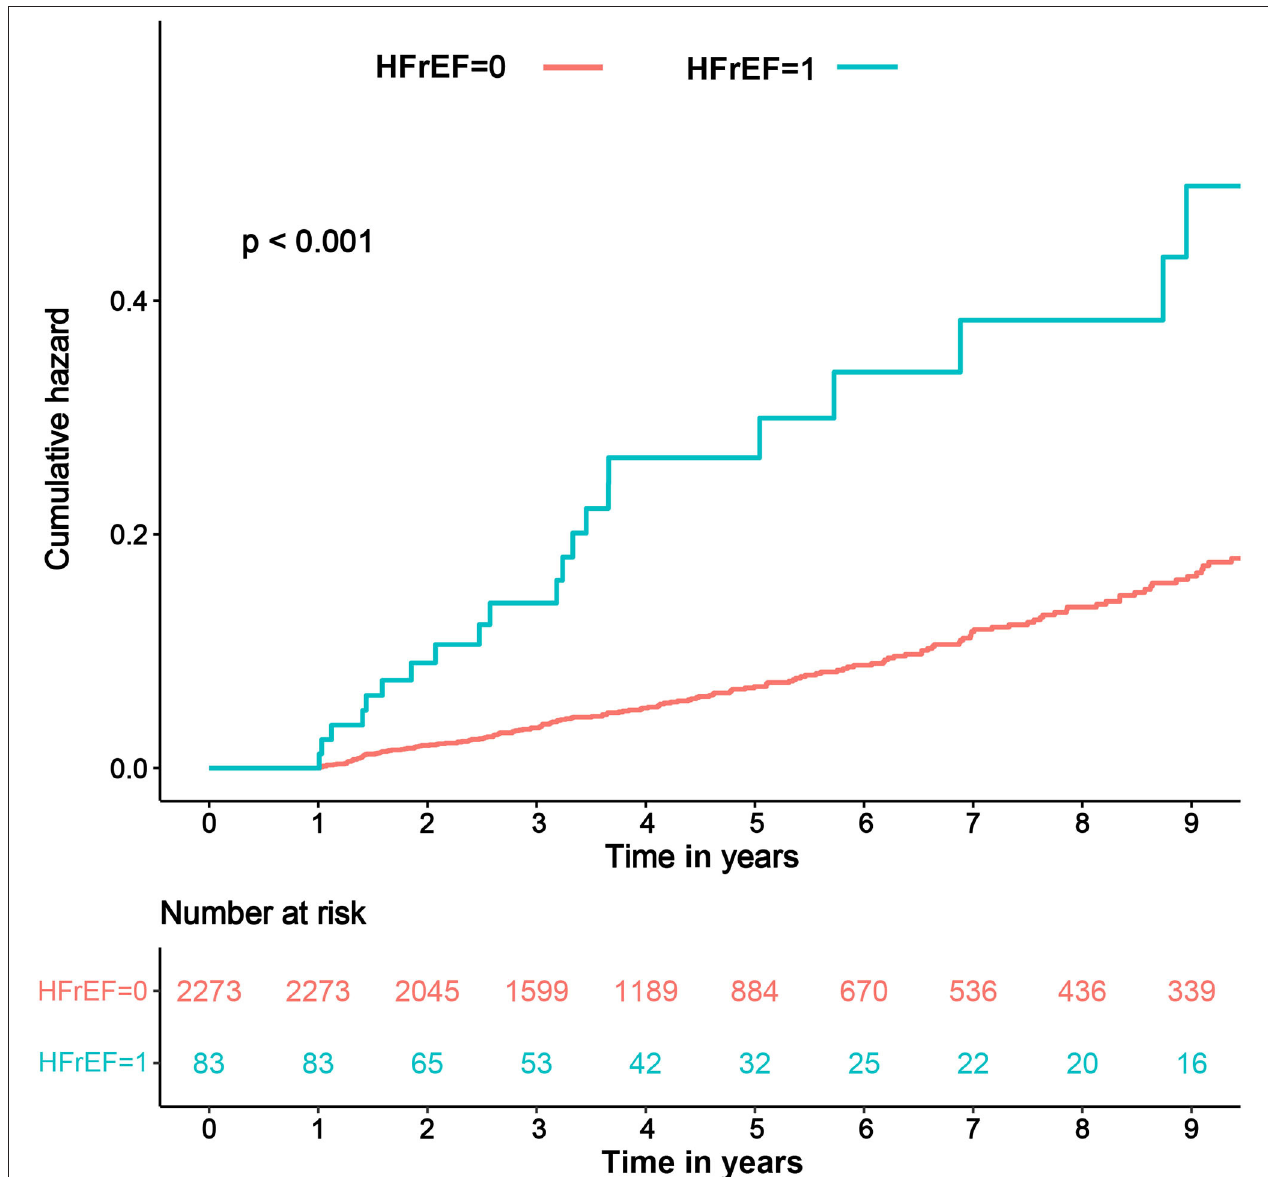
FIGURE 2 | Kaplan-Meier curve in terms of all-cause mortality in patients with and without HFrEF. HFrEF, heart failure with reduced ejection fraction; HFrEF = 1, patients with incident HFrEF; HFrEF = 0, patients without incident